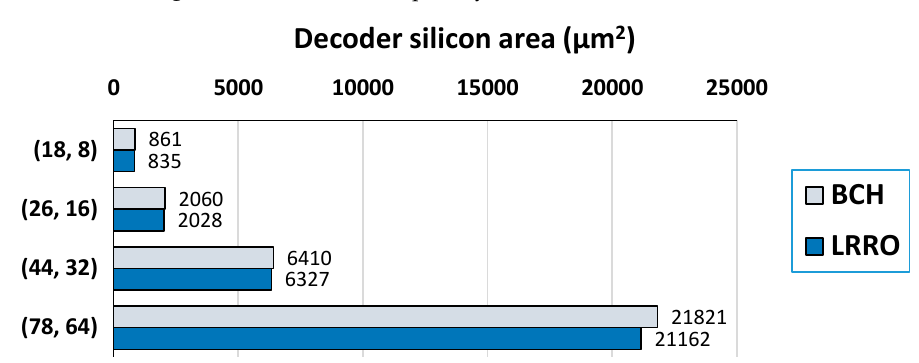
Figure 9. Silicon area occupied by the encoder circuits (in µm 2 ).